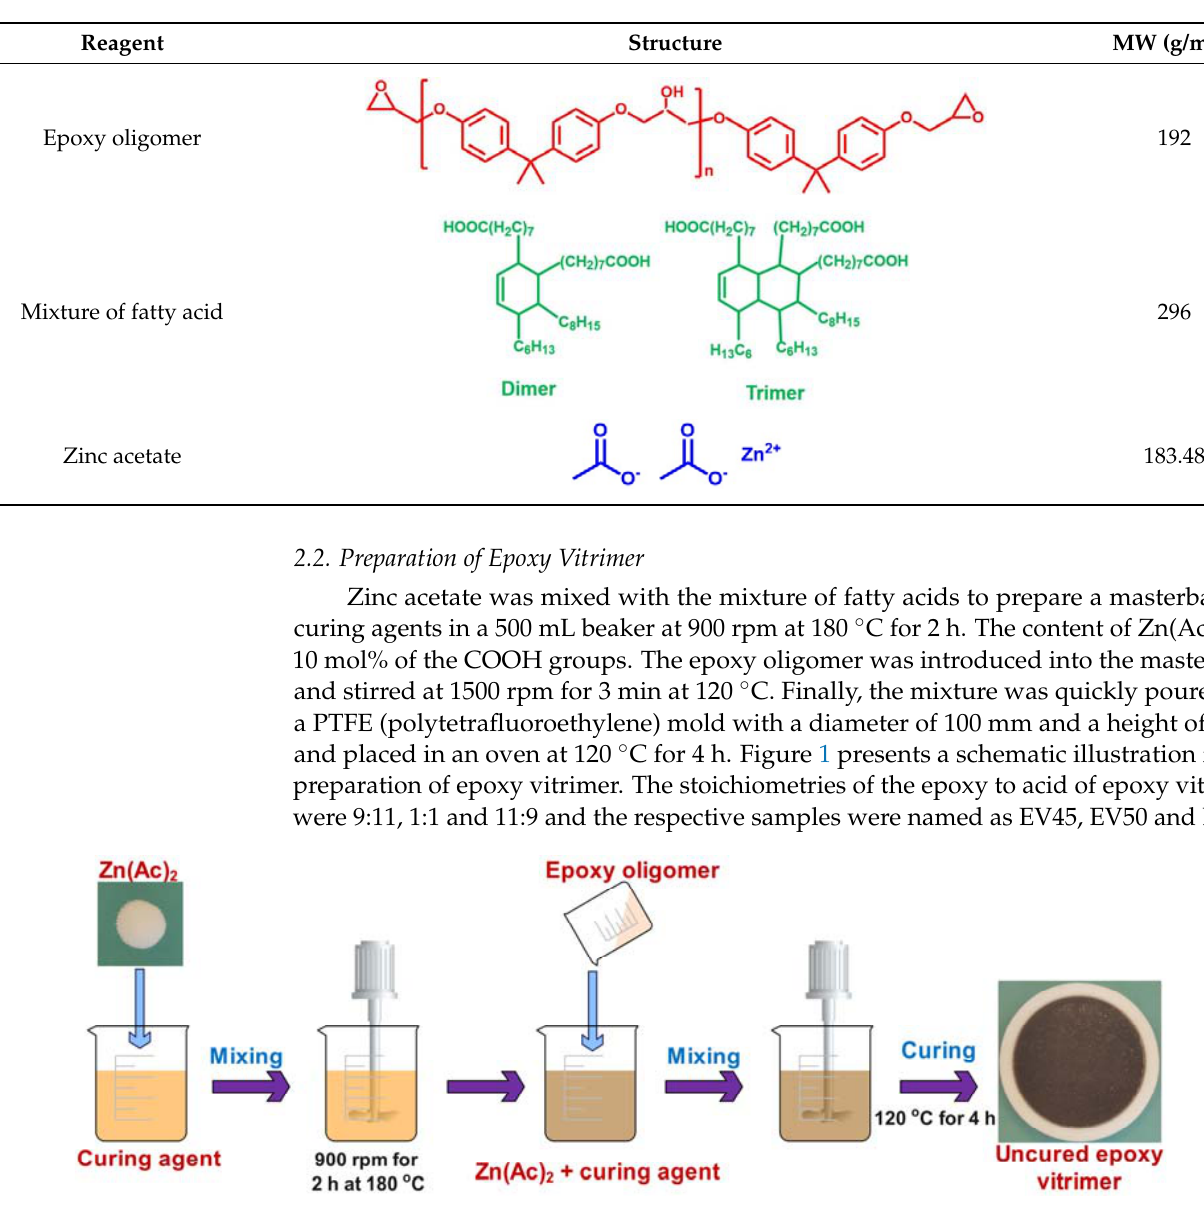
Table 1. Chemical structures and molecular weights (MWs) of reagents .